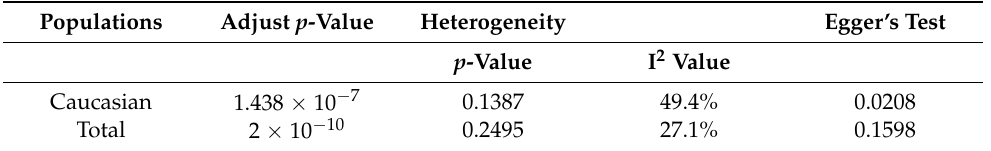
Table 2. Meta-analysis of the association between the rs4986790 SNP of the TLR4 gene and susceptibility to HIV infection.